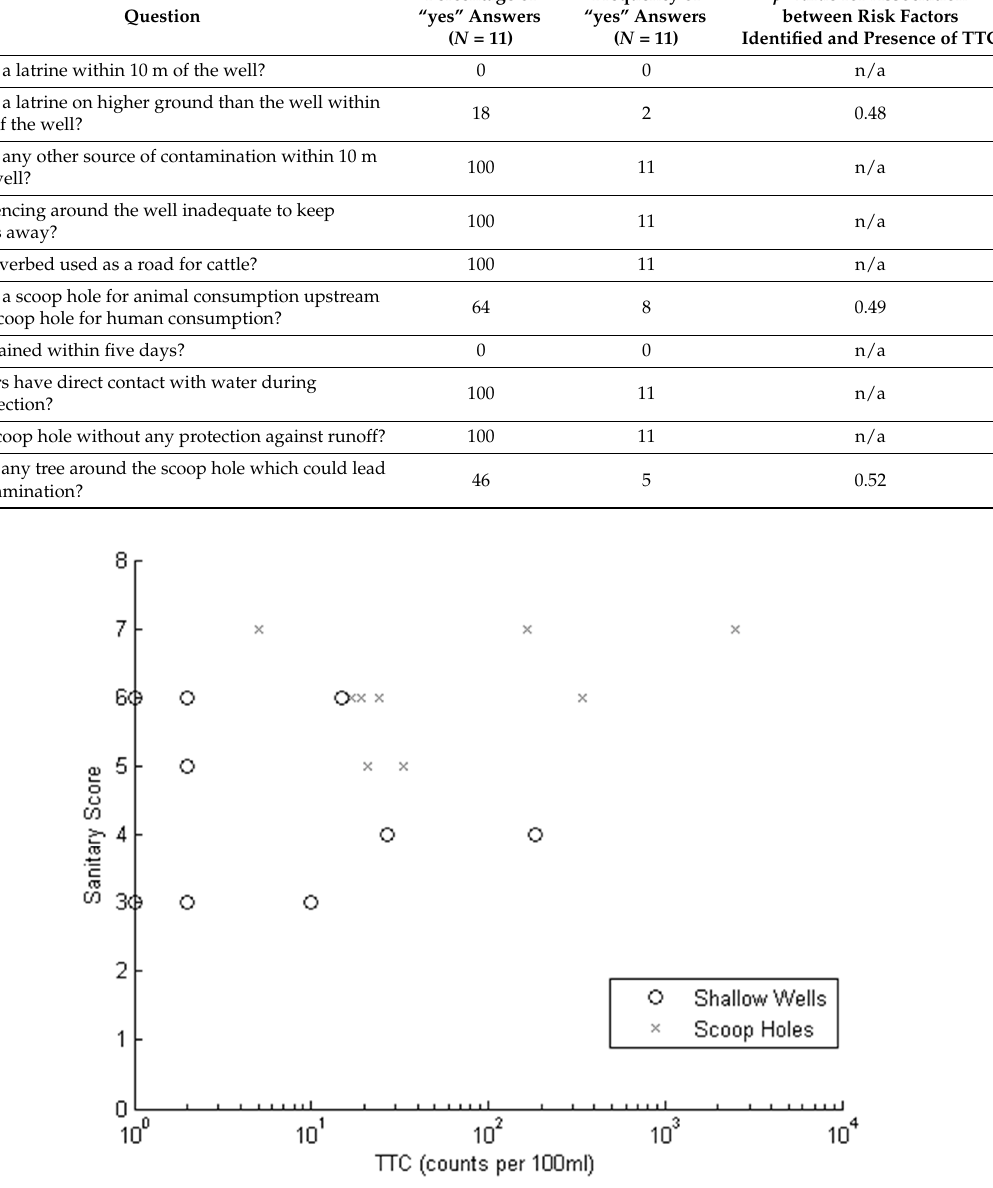
Figure 5. The plot of TTC against the sanitary score for field study 2.